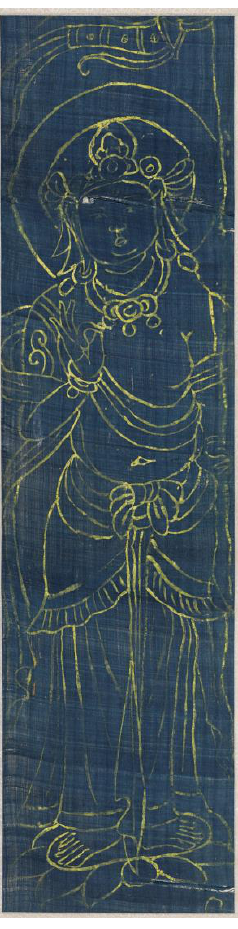
Figure 10. Banner of Bodhisattva , possibly part of a larger long banner, 10th century CE, color on silk, H. 165.0 cm, W. 36.8 cm, Bon 4019, National Museum of Korea. Photograph licensed under Creative Commons, reproduced with permission from National Museum of Korea, Seoul.